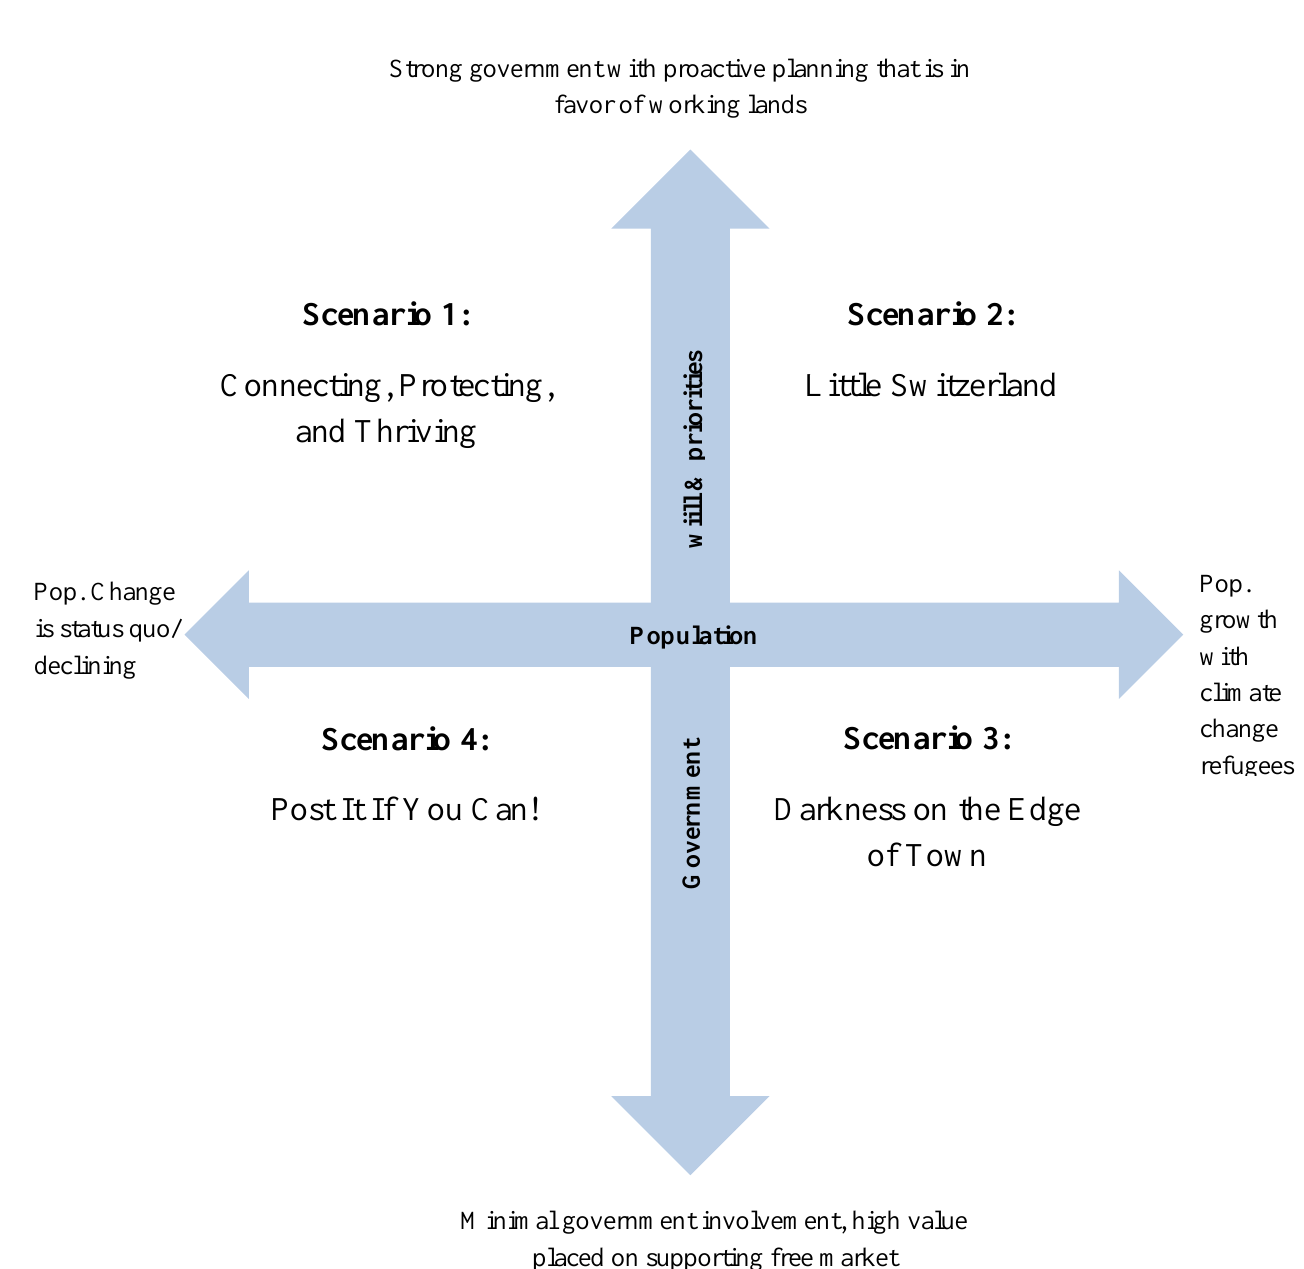
Fig. A2.1. Vermont scenario